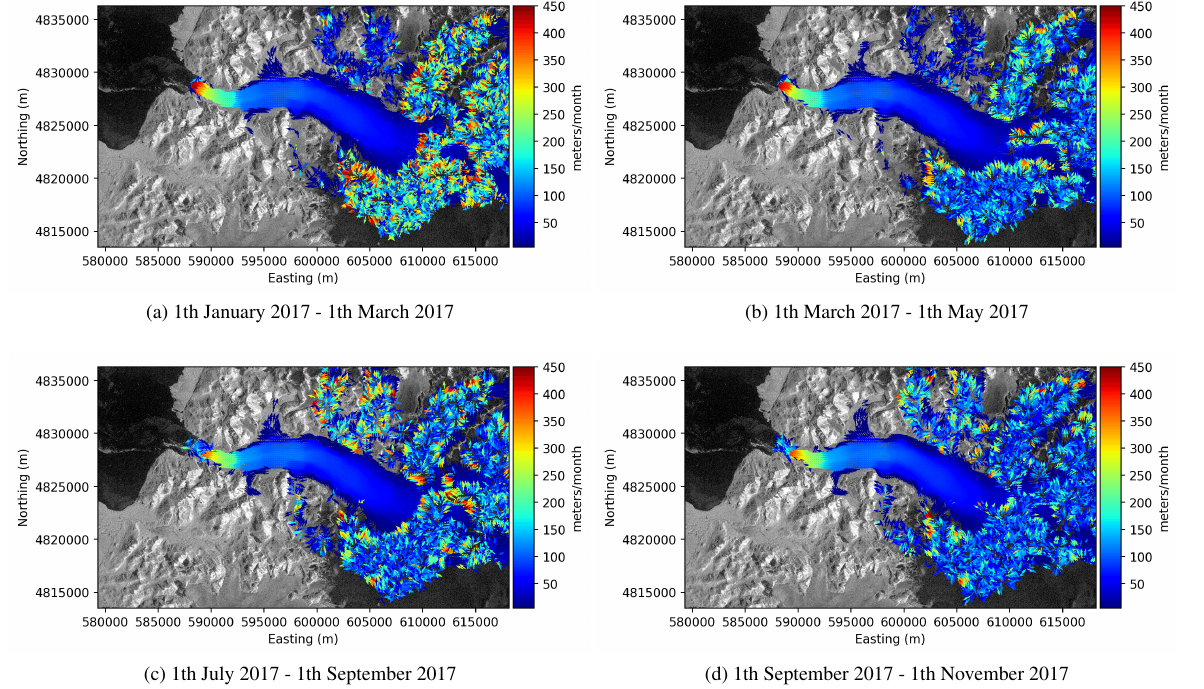
Figure 4. Temporal series of San Rafael Glacier surface velocity field